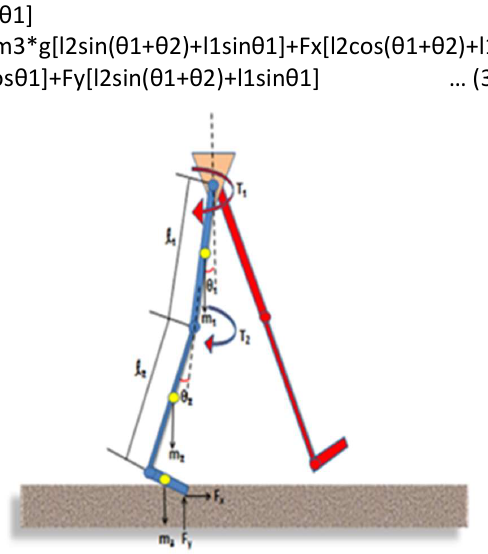
Fig. 3. Single limb stance with hip joint extension